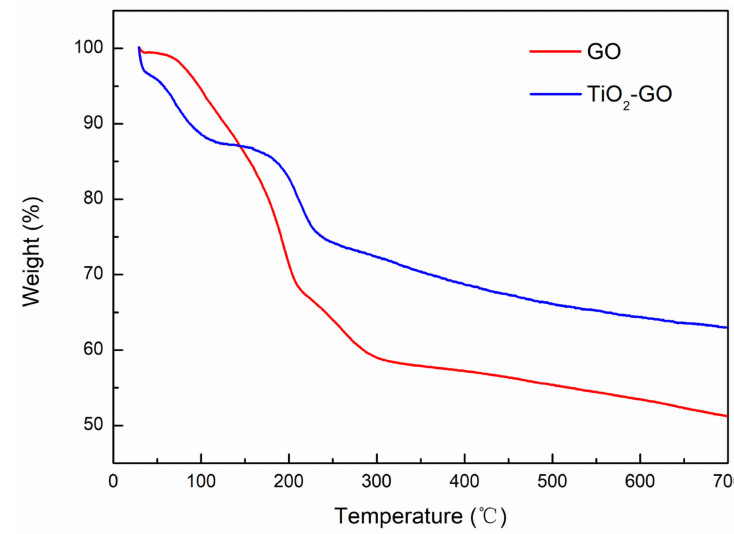
Figure 6. TGA curves of TiO 2 –GO and